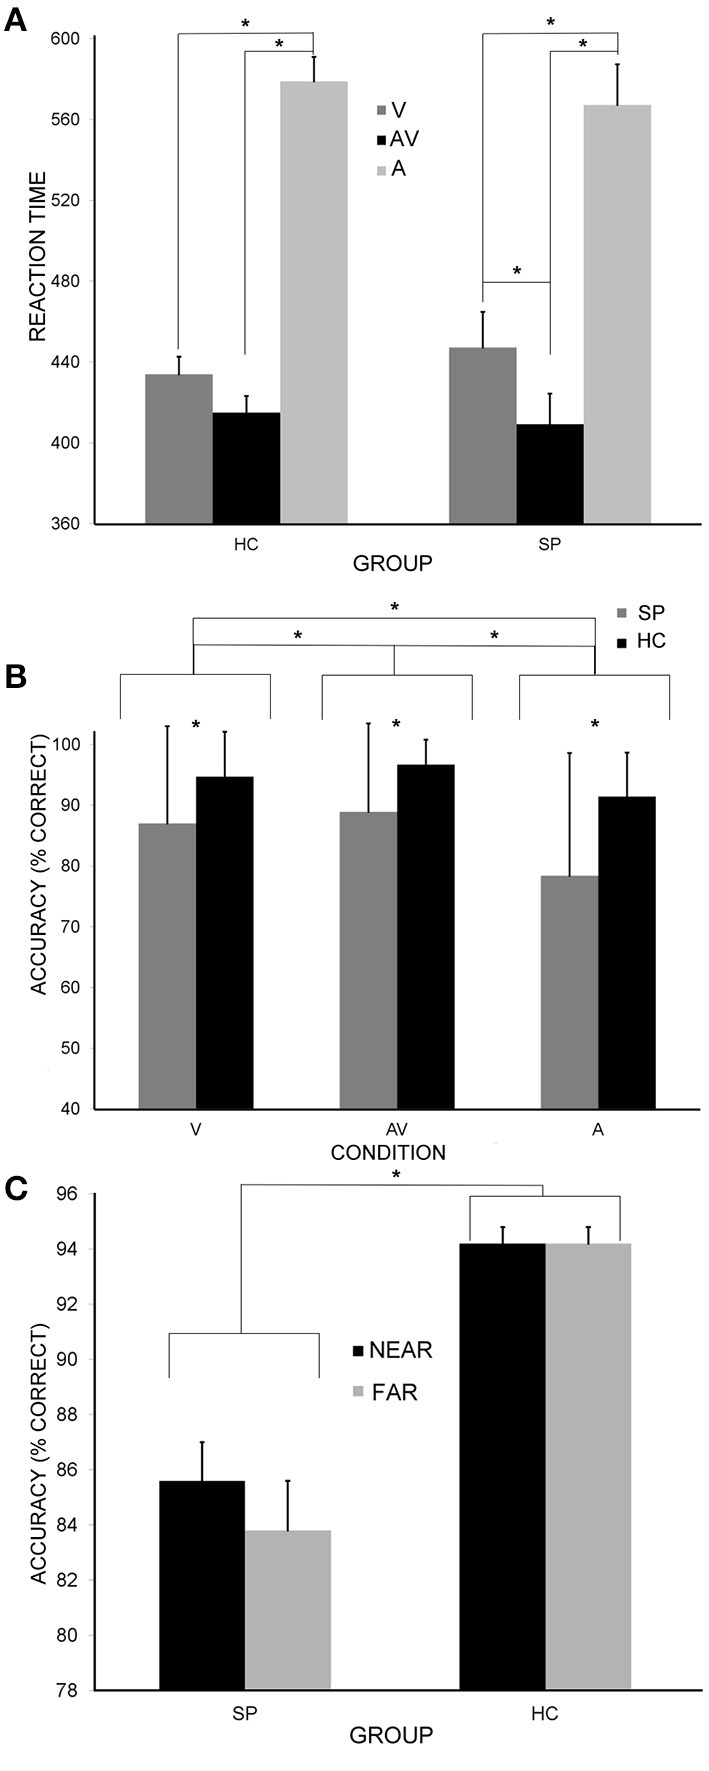
Behavioral differences. (A) Mean reaction times for the SP and HC group to unisensory (A and V) and multisensory (AV) stimuli. Significant main effects and interactions are denoted by asterisks. In addition to a main effect of condition, there was a group by condition interaction showing that SP had greater multisensory facilitation than HC—the fastest unisensory response (V) was significantly slower in SP, yet the AV RTs were equivalent by group. (B) Accuracy (% correct responses) for each group in response to unisensory (A and V) and multisensory (AV) stimuli. HC had significantly more correct responses to all three stimulus types compared to SP. (C) Accuracy for each group in response to near and far stimuli collapsed across conditions. HC had significantly more correct responses to both near and far stimuli compared to SP. SP had a significantly greater difference in near and far response accuracy compared to HC. Error bars represent s.e.m.